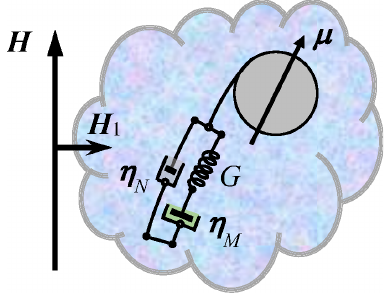
Figure 1. Sketch of a magnetic particle bearing a corona of Jeffreys medium. The system is set under constant field (cid:126) H , and the existing equilibrium is perturbed by the field (cid:126) H 1 switched on/off stepwise or alternating